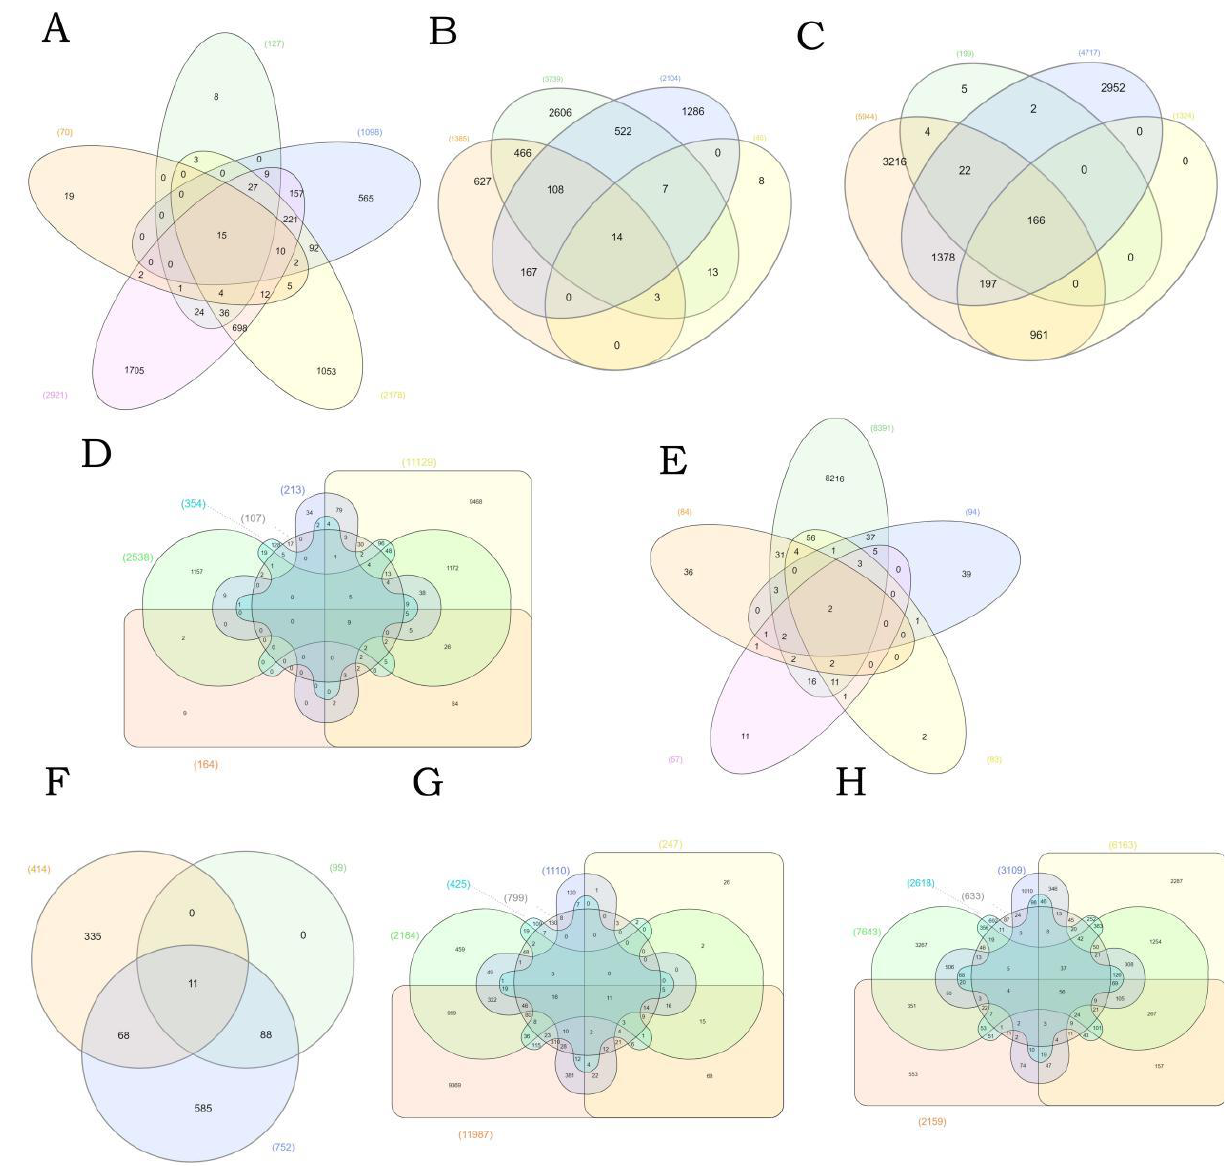
Figure 4. Venn diagrams of different types of water pollutants. The groups were created as follows: ( A ) perfluorinated chemicals: perfluorobutanesulfonic acid, perfluorodecanoic acid, perfluorooc- tane sulfonic acid, perfluorooctanoic acid, perfluorononanoic acid; ( B ) polybrominated diphenyl ethers: pentabromodiphenyl ether, 2,2 (cid:48) ,4,4 (cid:48) -tetrabromodiphenyl ether, decabromodiphenyl ether, hexabrominated diphenyl ether; ( C ) phthalate: dibutyl phthalate, diethyl phthalate, diethylhexyl ph- thalate, diisobutyl phthalate; ( D ) nanomaterials: Ag, aluminum oxide, cerium oxide, iron oxide, silica, ZnO; ( E ) insecticides: acetochlor, atrazine, carbendazim, isoproturon, metolachlor; ( F ) microcystins: cryptophycins, microcystin RR, microcystin-LF, microcystins; ( G ) pharmacologies: